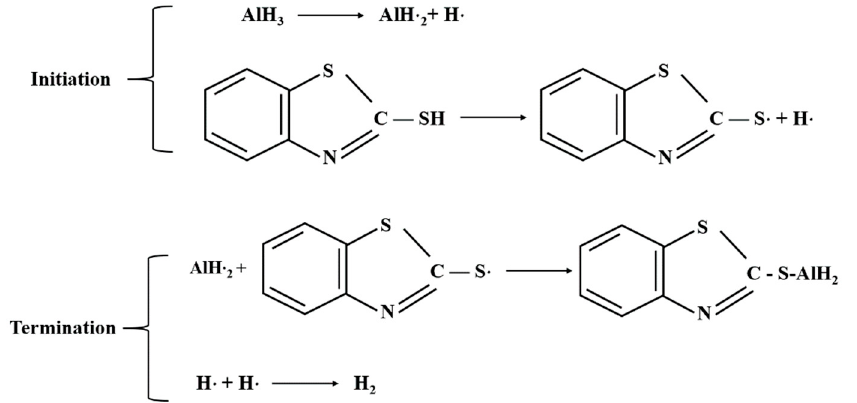
Figure 13. Stabilization mechanism of 2 ‐ Mercaptobenzothiazole (MBT) and α (cid:3398) AlH (cid:2871)